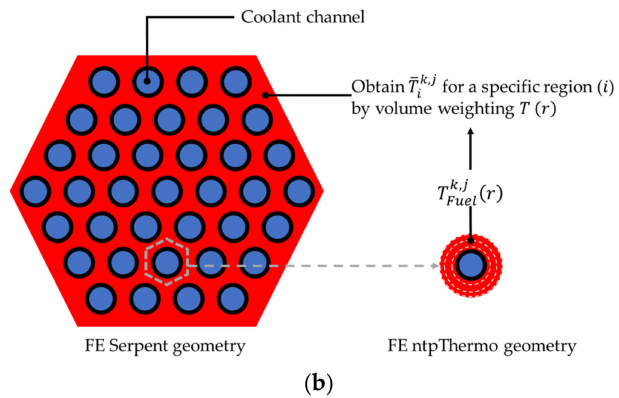
Figure 3. T/H field mapping to Serpent Model for ( a ) MEs; ( b )